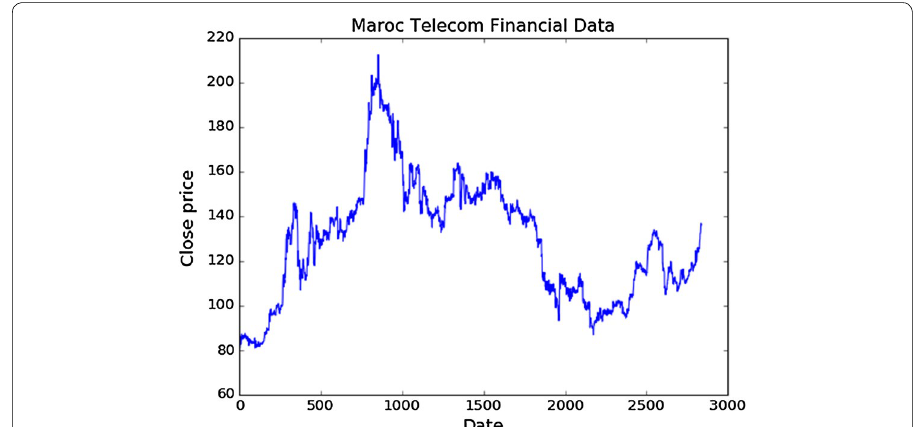
Fig. 4 Maroc Telecom Financial Tme